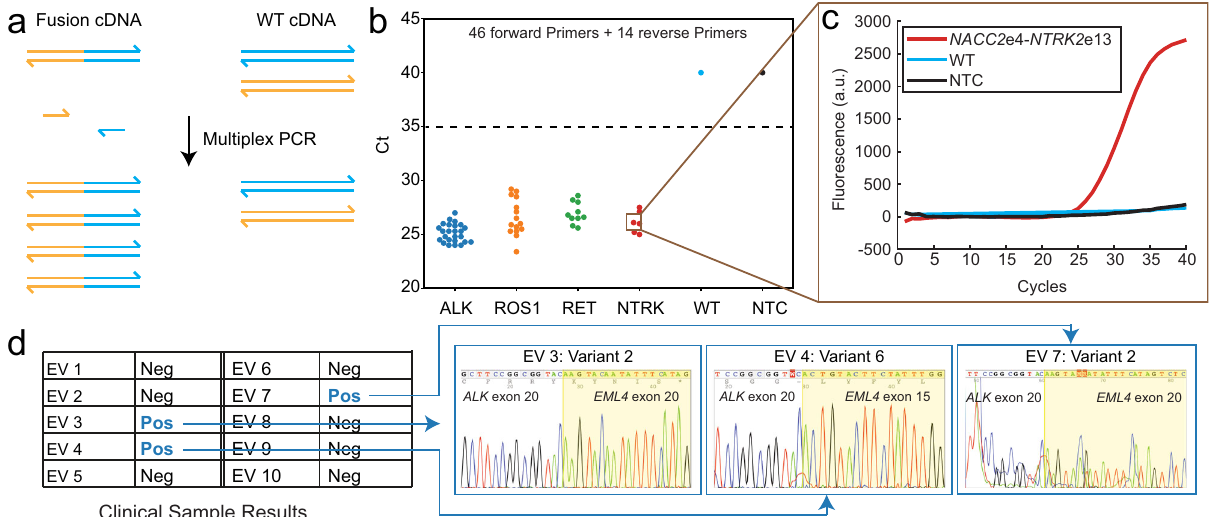
Fig. 5 Highly multiplexed qPCR detection of gene fusions using SADDLE-designed primer sets. a Complementary DNA (cDNA) prepared through reverse transcription of RNA can have known target sequences at the exon breakpoints. Although it is trivial to design a single-plex qPCR assay to detect a single known fusion, such as BCR-ABL1 36 , we are not aware of any reports of highly multiplexed qPCR assays to simultaneously detect ≥ 10 different gene fusion cDNA species. For this assay, we designed a 60 primer set (46 forward, 14 reverse) that together can amplify 56 distinct gene fusion types commonly observed in non-small-cell lung cancer 37 . b Summary of observed qPCR cycle threshold (Ct) values for the 56 reactions, each with 1 of the 56 synthetic fusion DNA species across 6 genes (ALK, ROS1, RET, and NTRK1/NTRK2/NTRK3), each with 1700 copies. WT indicates wildtype commercial cDNA, and NTC indicates no template control. See Supplementary Section S8 for additional details and experimental results, including Sanger sequencing traces of each reaction product. c Example qPCR trace showing detection of the fusion DNA sequence joining NACC2 exon 4 to NTRK2 exon 13. d Clinical sample results on cDNA reverse transcribed from RNA from extracellular vesicles. Samples 3, 4, and 7 tested positive for a gene fusion, and sequence alignment of the Sanger sequencing results (right panels) show the exact identi fi es of the